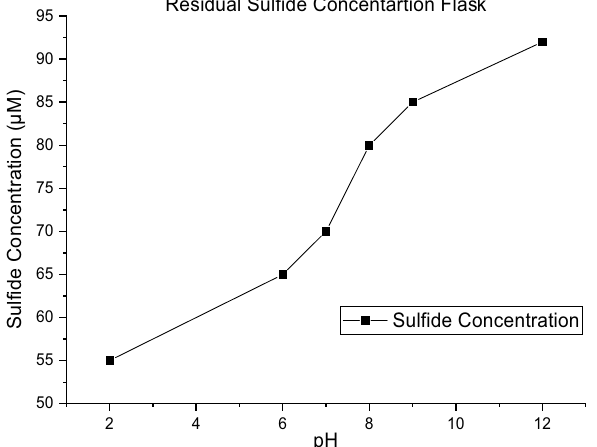
Figure 7. Residual sulfide versus various pH values in sulfide introduced to medium without biosulfur.